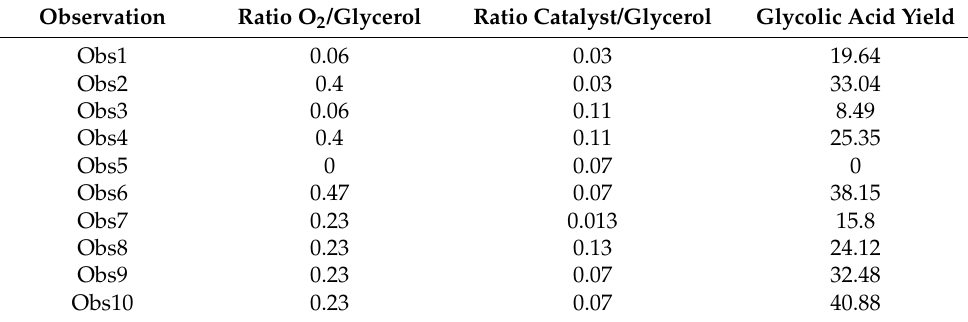
Table 7. Experimental results obtained at each operating condition of CCD